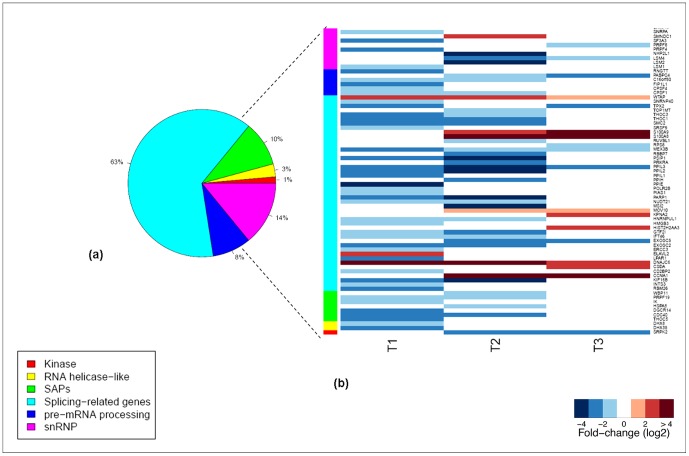
Protein families of the differentially expressed splicing factors.(a) Protein family distribution of the differentially expressed splicing factors; (b) Heatmap with the fold changes (log(2)) observed for the differentially expressed splicing factors, at the three evaluated timepoints (T1: 4 h; T2: 8 h; T3: 18 h), grouped by protein family. The genes and respective logfold changes are presented in detail in Table S6.